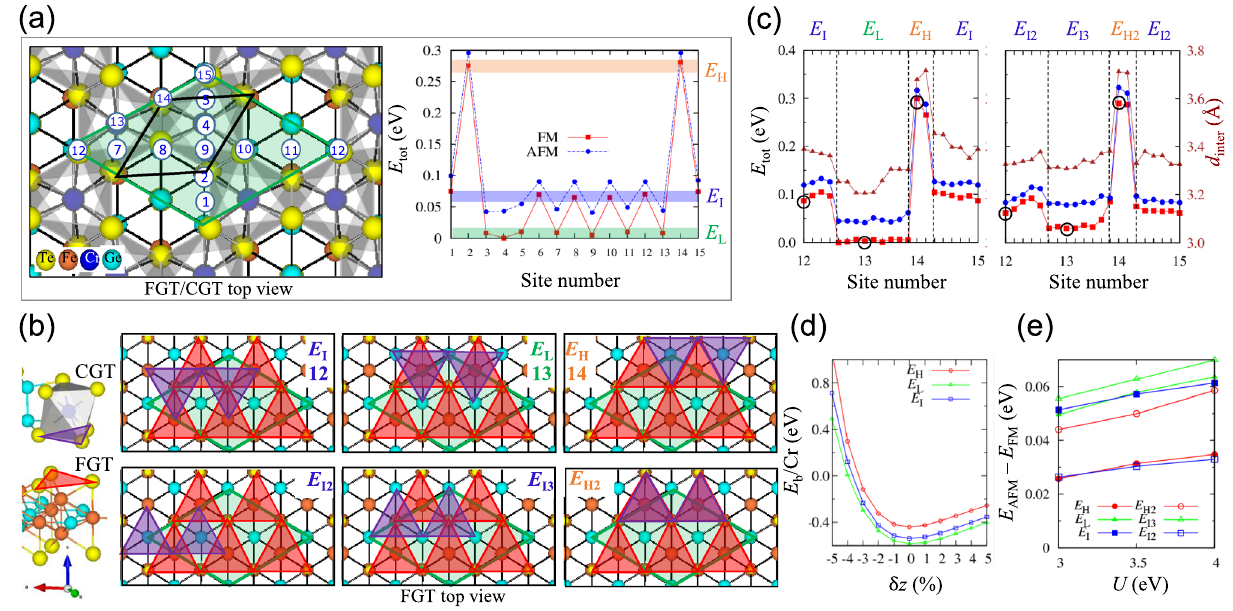
Figure 2. ( a ) Top view of FGT/CGT moiré supercell with a twist angle of 30° (green diamond) in the left panel, and total energy comparison of 15 stacked structures with the ferromagnetic (FM)/antiferromagnetic (AFM) spin alignment between the FGT and CGT layers in the right panel. The calculations are done using the spin-polarized optB88 vdW method. The supercell size is the same as the in-plane ML CGT unit cell size. A black diamond indicates the in-plane ML FGT unit cell. The numbered sites along two diagonals and one in-plane lattice indicate 15 stacked structures. The 15 stacked structures were made by sliding CGT over the numbered sites while FGT was fixed. The FM total energy is classified into three energies: E I , E L , and E H . ( b ) Six representative stacked structures of E I (site 12), E L (site 13), E H (site 14), E I2 , E I3 , and E H2 . The background lattice shows the FGT top view. The red (purple) triangles comprise the interface Te FGT (Te CGT ) atoms. Two purple triangles are situated above Fe1 FGT atoms for E I , Ge FGT atoms for E L , and Te FGT atoms for E H . E I2 , E I3 , and E H2 are obtained by rotating the CGT layer 180° and relaxing it. ( c ) FM/AFM total energy variation from E I ( E I2 ) through E L ( E I3 ) to E H ( E H2 ) representative structures with FM/AFM spin alignment and the interlayer distance, d inter , depending on FM stacked structures. The total energy and structures are obtained using the spin-polarized optB88 vdW method. The red, blue, and brown colors indicate FM, AFM, and d inter , respectively. ( d ) Binding energy, E b , per Cr atom of E H , E L , and E I along the z -axis regarding small displacements. ( e ) Total energy difference between FM and AFM spin alignments obtained by using the noncollinear PBE + U + SOC method, when U is in the range 3–4 eV and the exchange interaction is J = 1.0 energy denoted by red arrows. On the other hand, the unfolded band structures of CGT (HB CGT) exhibit a reduced bandgap compared with that of ML CGT, and the conduction bands of HB CGT cross the Fermi level, generating an n-type CGT layer. Also, unexpected bands of HB CGT are observed as indicated by a blue arrow compared to ML CGT. These intriguing electronic features of moiré heterobilayer motivate us to examine the critical elements that influence band structures. To investigate the electronic structures in terms of stacked structures, we constructed small moiré supercells of the FGT/CGT heterobilayer forming only one stacked structure with a twist angle of 30° and △ = 1.36%, as 1 in-plane unit shown in Fig. 2a. The in-plane supercell indicated by a solid green diamond is equal to the 1 × √ 3 in-plane supercell of ML FGT, drawn by an cell of ML CGT and also corresponds to the 30° rotated √ 3 × open black diamond. Inside the supercell, there are two CrTe 6 octahedrons. ML FGT is an Ising-type FM metal, whereas ML CGT is an Ising-type FM semiconductor. To predict the